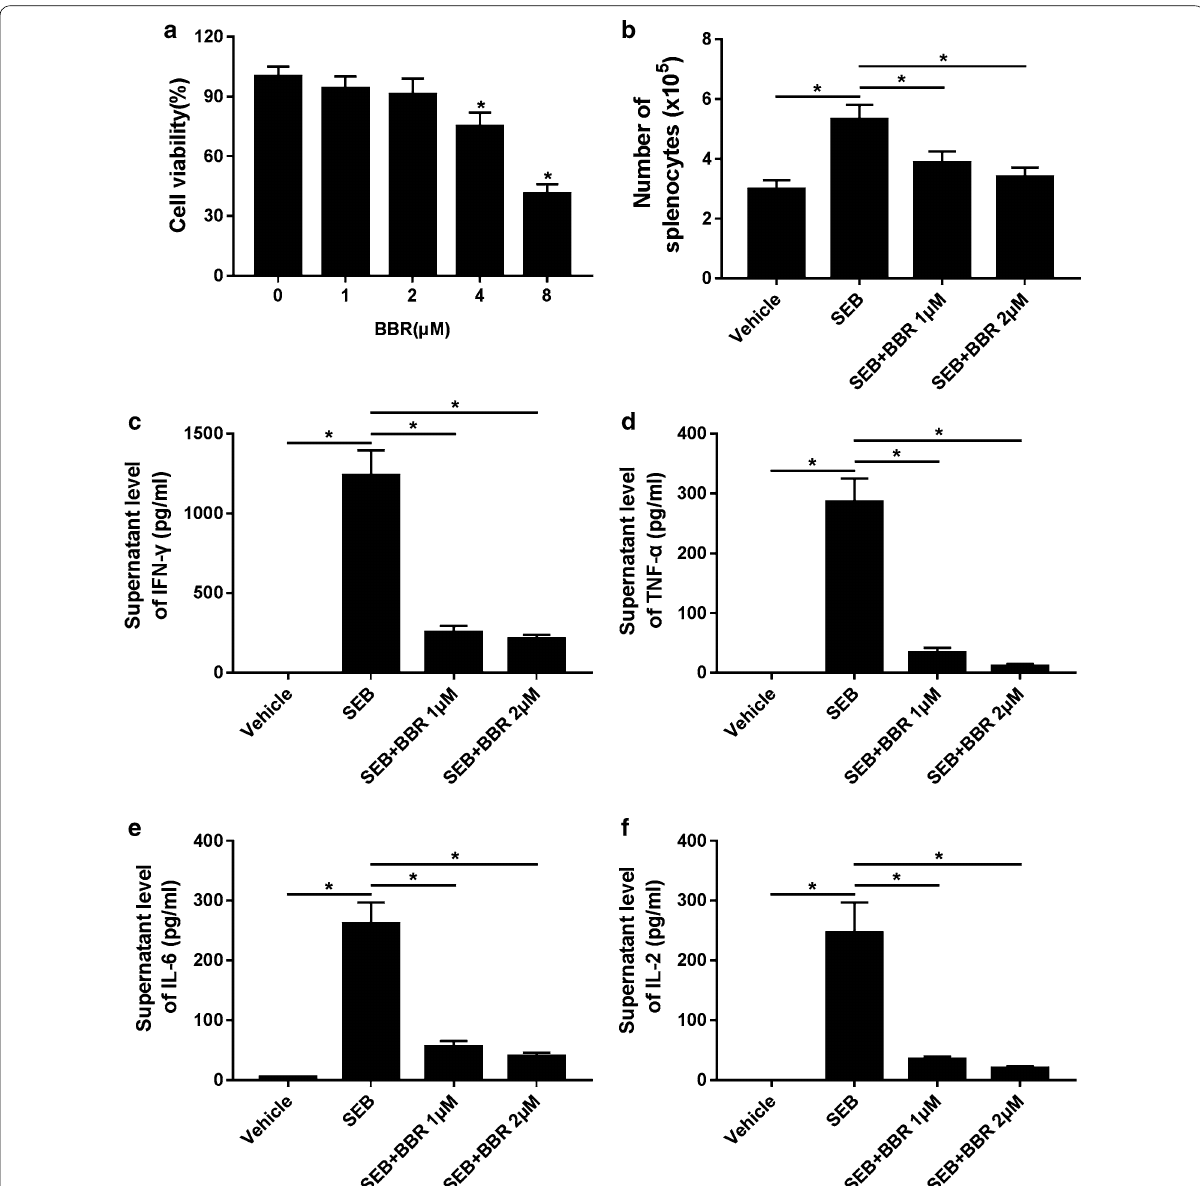
Fig. 3 BBR suppressed SEB-induced activation of splenocytes and pro-inflammatory cytokine release in splenocytes. a BBR-induced cytotoxicity against splenocytes was assessed by MTT assay. b The number of the treated splenocytes was detected by flow cytometry analysis. The levels of IFN-γ c , TNF-α d , IL-6 e and IL-2 f in the supernatants of splenocytes were measured by ELISA. * P < 0.05. SEB group versus Vehicle or SEB